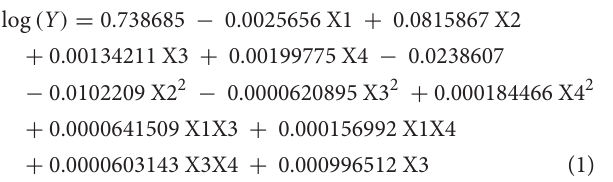
Frontiers in Sustainable Food Systems |